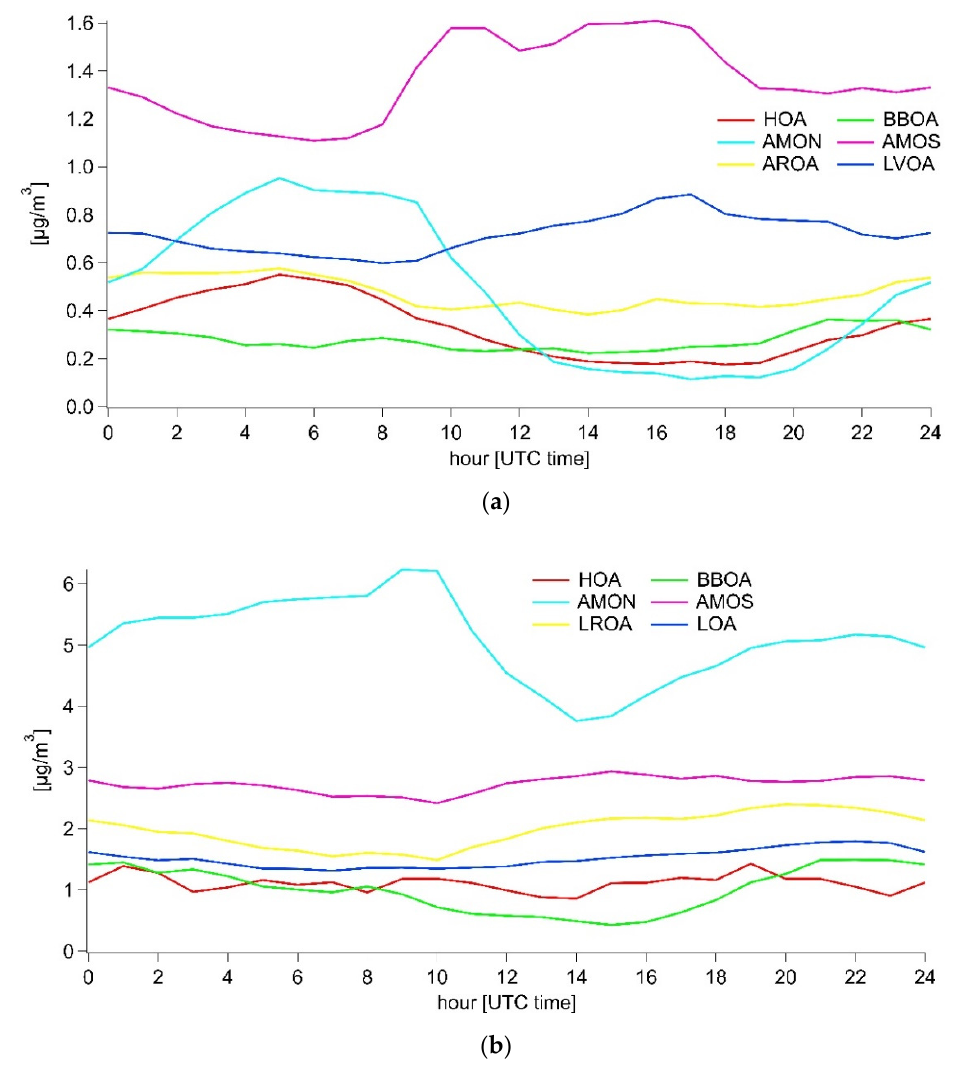
Figure 7. Average diurnal cycles of all factors during ( a ) summer period and ( b ) winter period.